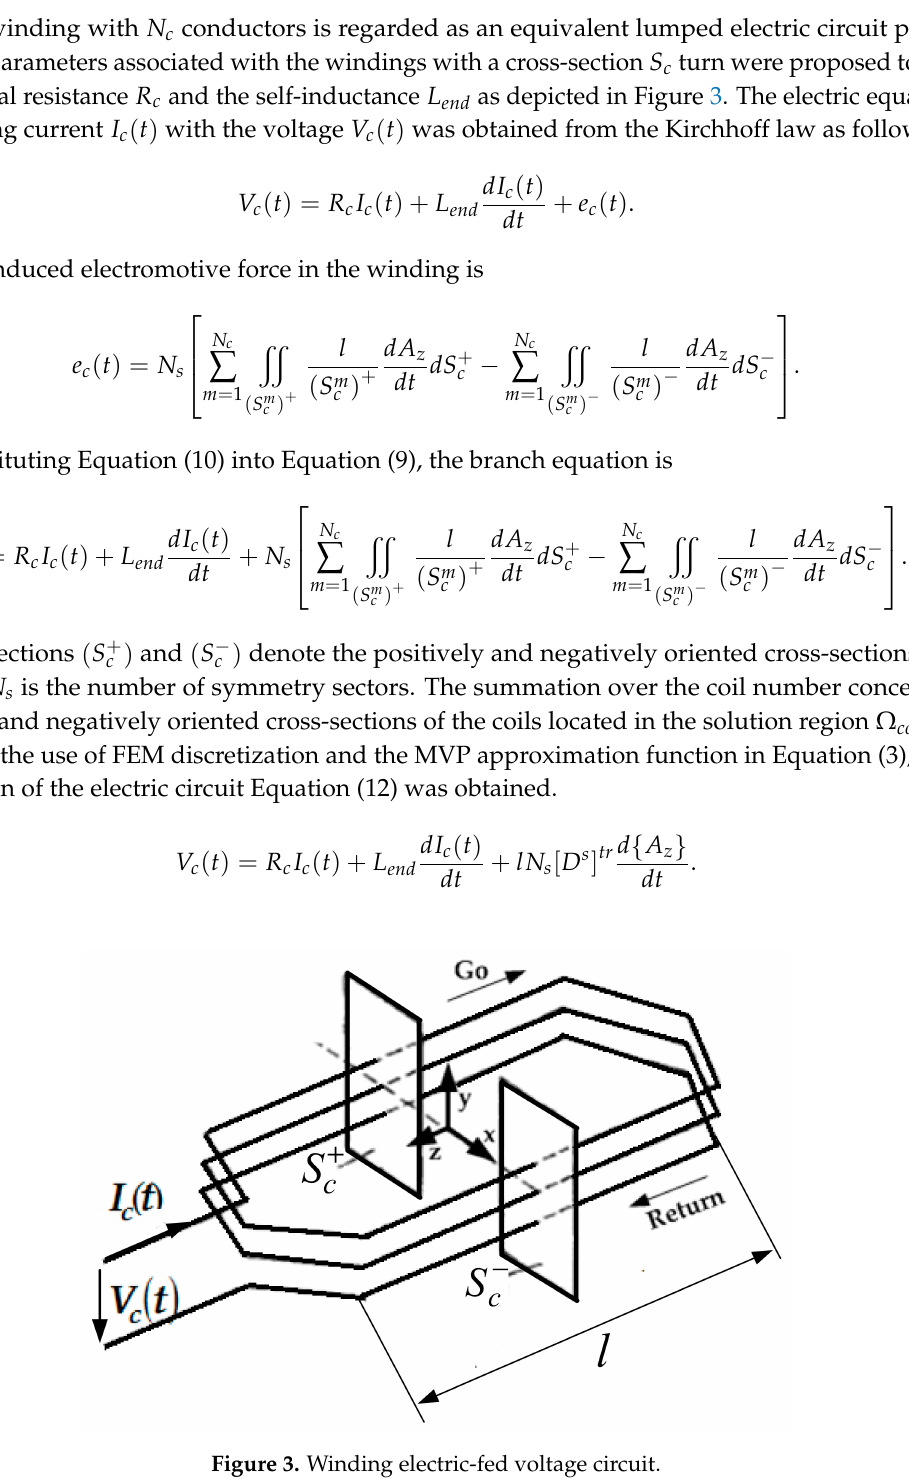
Figure 3. Winding electric-fed voltage